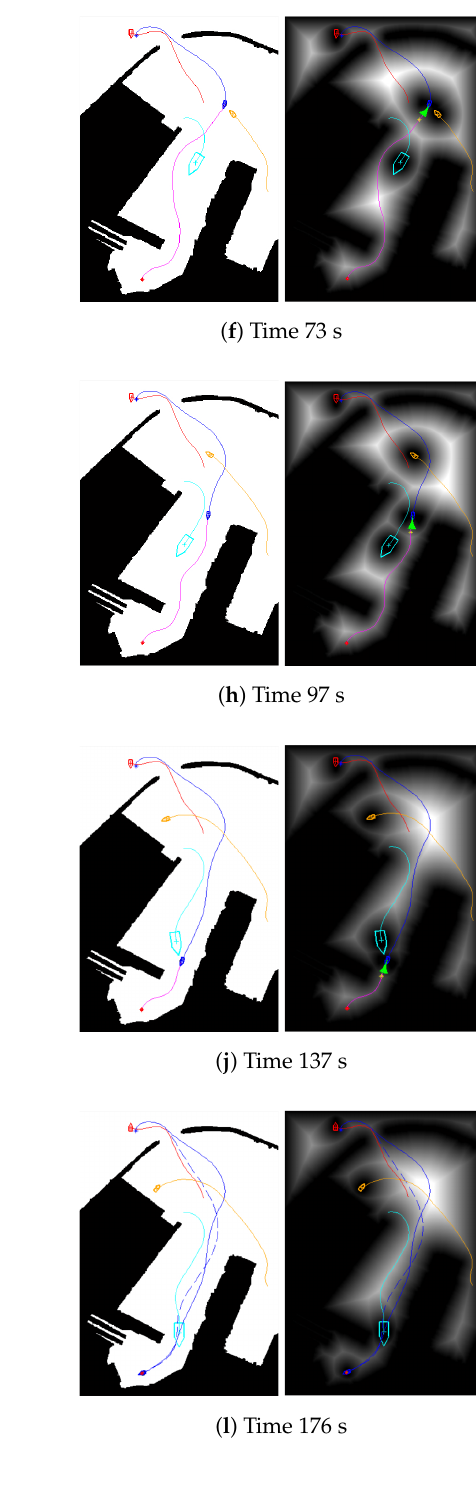
Figure 21. The motion sequence diagram of the unmanned surface vehicle with multiple target vessels in a real environment. ( a ) Time 5 s; ( b ) Time 29 s; ( c ) Time 33 s; ( d ) Time 37 s; ( e ) Time 69 s; ( f ) Time 73 s; ( g ) Time 77 s; ( h ) Time 97 s; ( i ) Time 121 s; ( j ) Time 137 s; ( k ) Time 161 s; ( l ) Time 176